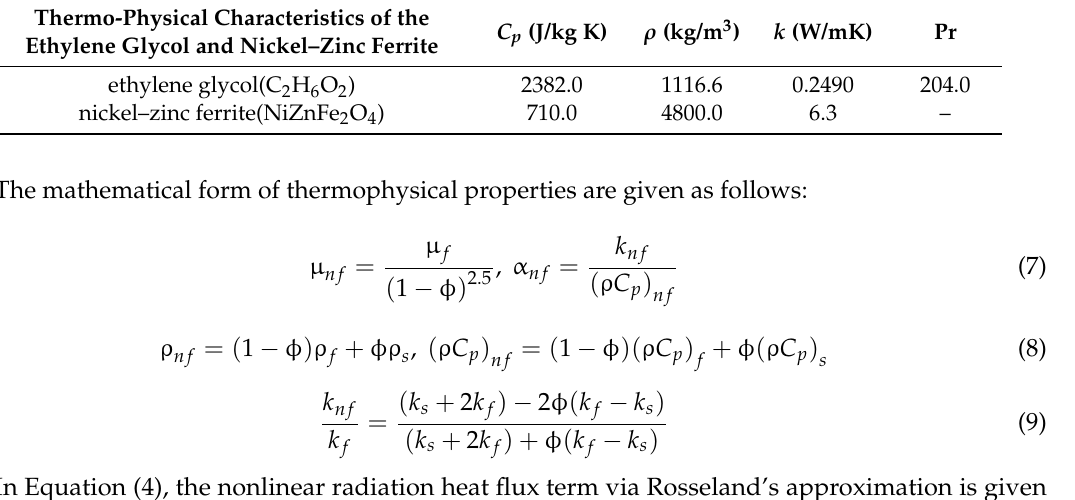
Table 1. The values of C p , ρ , and k for ethylene glycol and NiZnFe 2 O 4 (nickel–zinc ferrite) [28–33]. Thermo-Physical Characteristics of the C p (J/kg Ethylene Glycol and Nickel–Zinc Ferrite